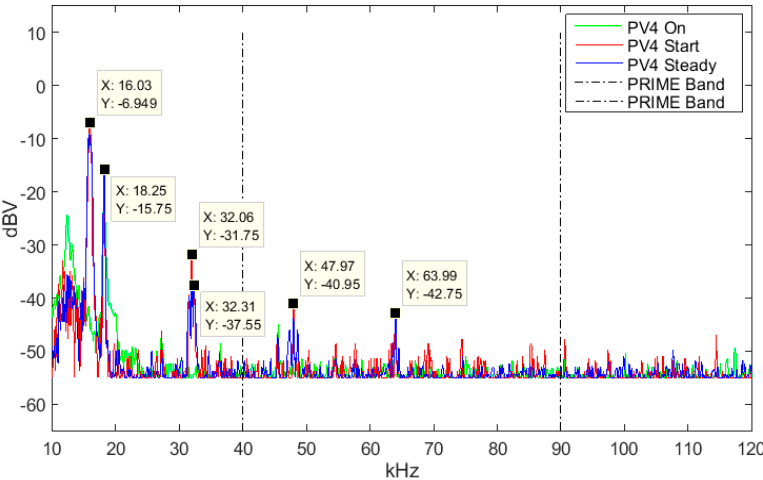
Figure 16. Spectrum recorded at the PV4 inverter SM with the rest of surrounding devices connected.